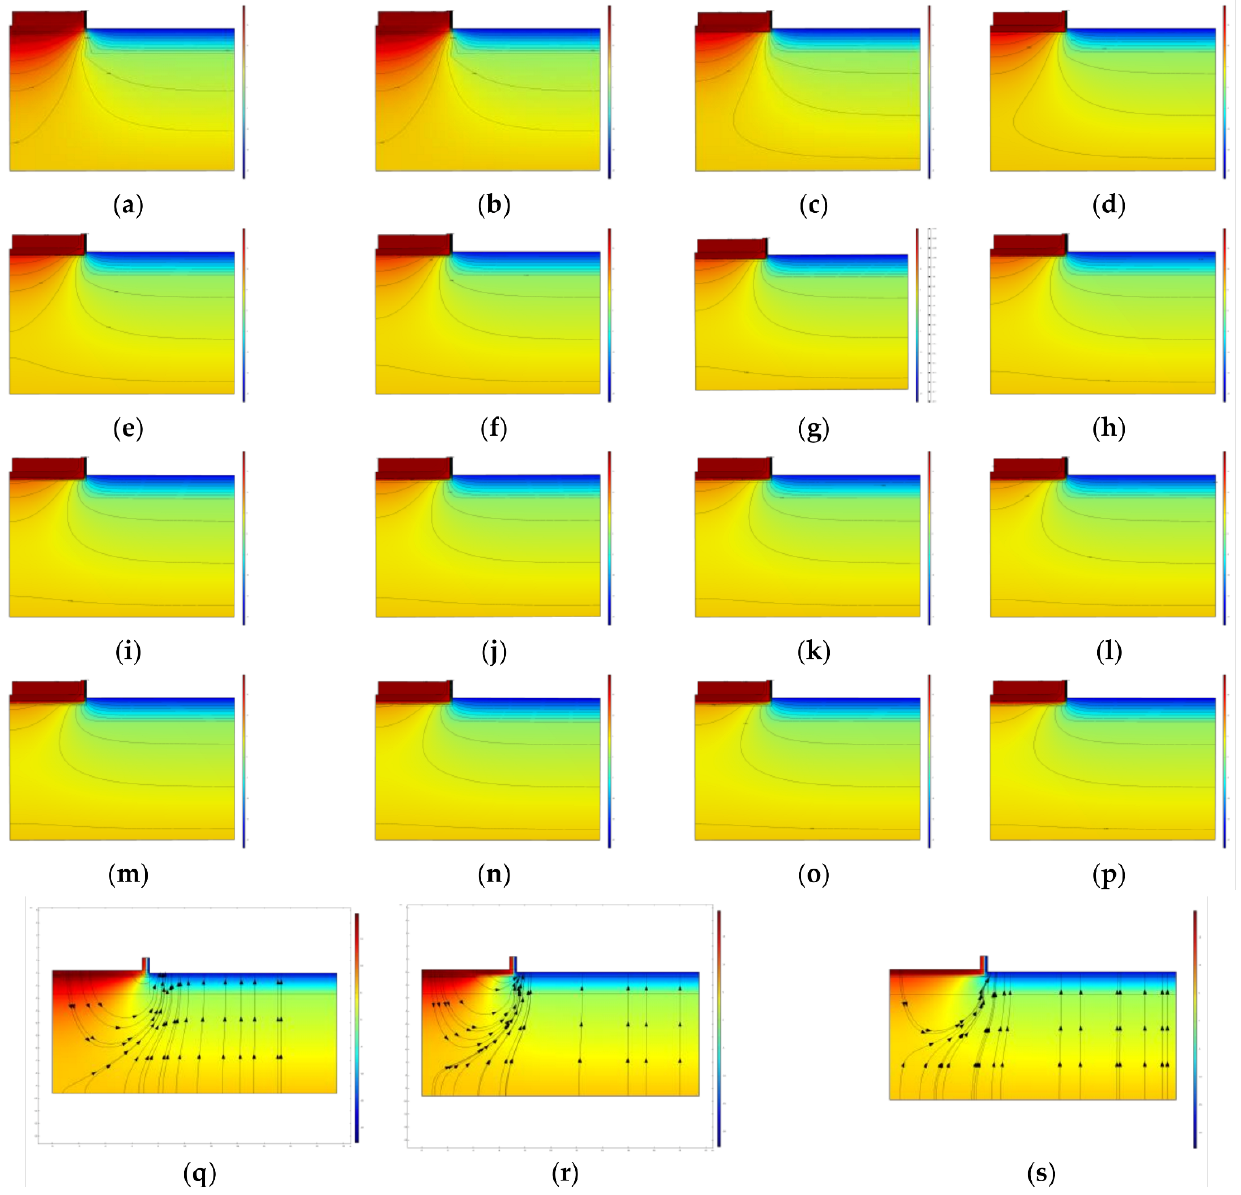
Figure 7. Group B model temperature distribution map. ( a ) Model B1 temperature distribution, ( b ) Model B2 temperature distribution, ( c ) Model B3 temperature distribution, ( d ) Model B4 tem- perature distribution, ( e ) Model B5 temperature distribution, ( f ) Model B6 temperature distribution, ( g ) Model B7 temperature distribution, ( h ) Model B8 temperature distribution, ( i ) Model B9 tempera- ture distribution, ( j ) Model B10 temperature distribution ( k ) B11 model temperature profile, ( l ) B12 model temperature profile, ( m ) B13 model temperature profile, ( n ) B14 model temperature profile, ( o ) B15 model temperature profile, ( p ) B16 model temperature profile, ( q ) B1 heat flow direction profile, ( r ) A1 heat flow direction profile, ( s ) B6 heat flow direction